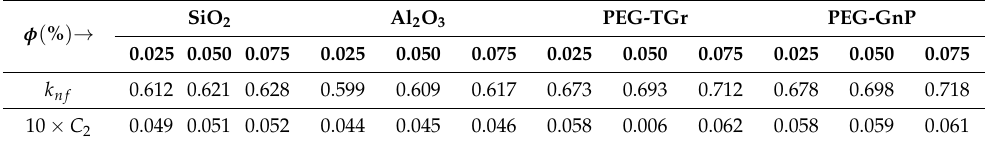
Table 3. The values of curve fitting parameters in Equation (4).